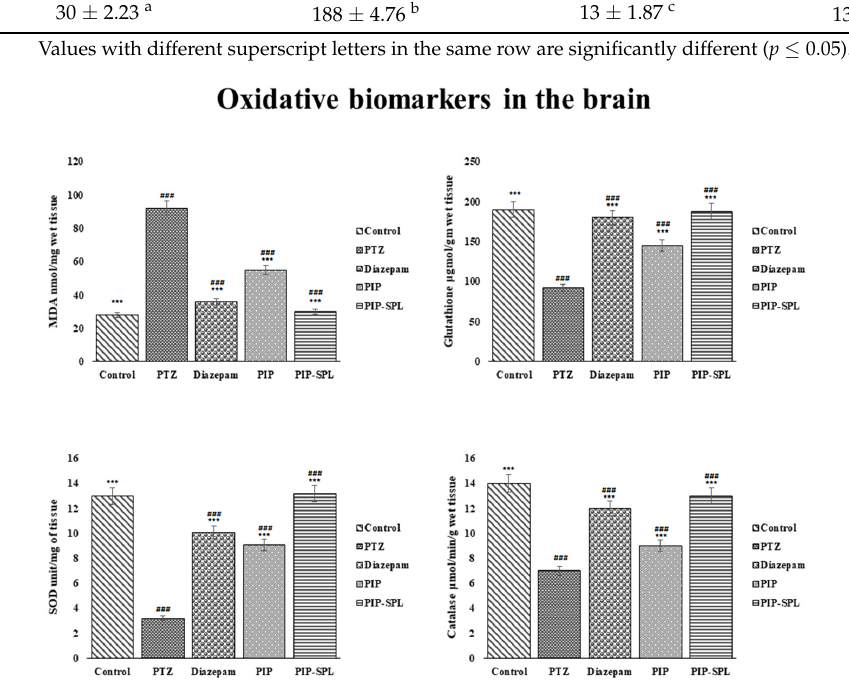
Values with different superscript letters in the same row are significantly different ( p ≤ 0.05).